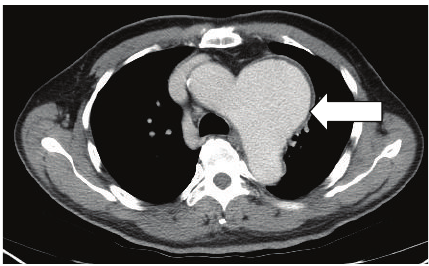
Figure 3: Transverse chest CT scanning, arrow indicated the aortic aneurysm.